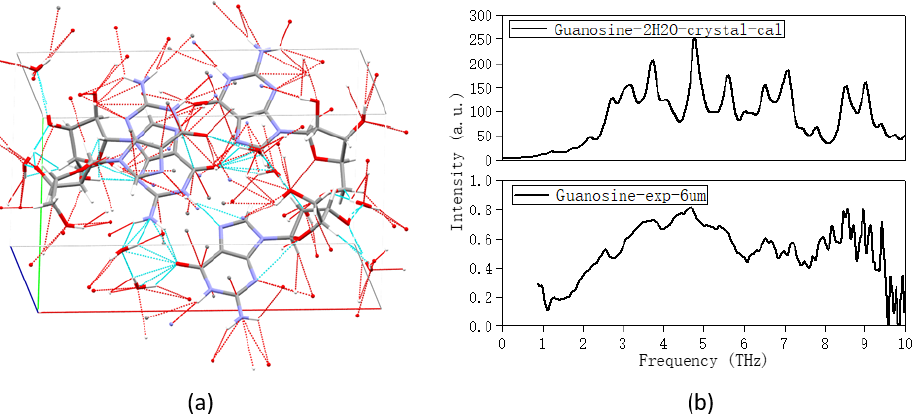
Figure 7. ( a ) The crystal structure of guanosine dihydrate; ( b ) comparison of the calculated (guanosine dihydrate, crystal structure) and experimental (crystalline guanosine) spectra. Table 3. Experimental and calculated THz vibrational frequencies and corresponding vibrational modes for anhydrous guanosine powder and dihydrate guanosine crystal.